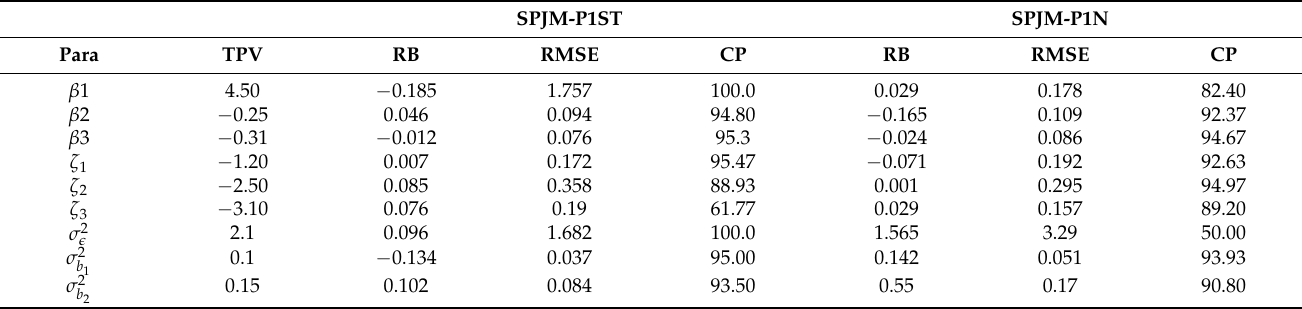
Table 4. Simulation results. The posterior mean estimate (est), relative bias (RB), root mean square (RMS) error and coverage probability (CP) for each parameter of the joint